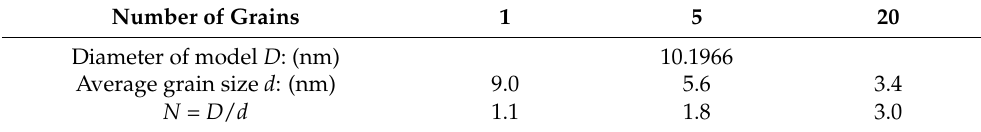
Figure 2. The distribution of specific grain sizes in different Ni 50.8 Ti cylinder models. Each grain is approximately regarded as a sphere. The pink bar graph represents the grain size of the single crys- tal model, with an average value of 9.0 nm; The blue bar graph represents the grain size of the polycrystalline model with 5 grains, and the average grain size is 5.6 nm; The purple bar graph represents the grain size of the polycrystalline model with 20 grains, and the average grain size is 3.4 nm. Table 2. The diameter D , average grain size d , and scale parameter N in different NiTi models. Number of Grains